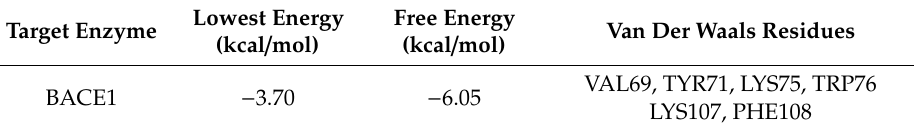
Figure 2. The best docking poses of sulforaphane ( a ) with BACE1. Magnified view of the binding site for ligand–target enzyme complex ( b ). The hydrophobic interaction diagram of BACE1 and sulforaphane ( c ). Table 3. Molecular interaction of BACE1 and